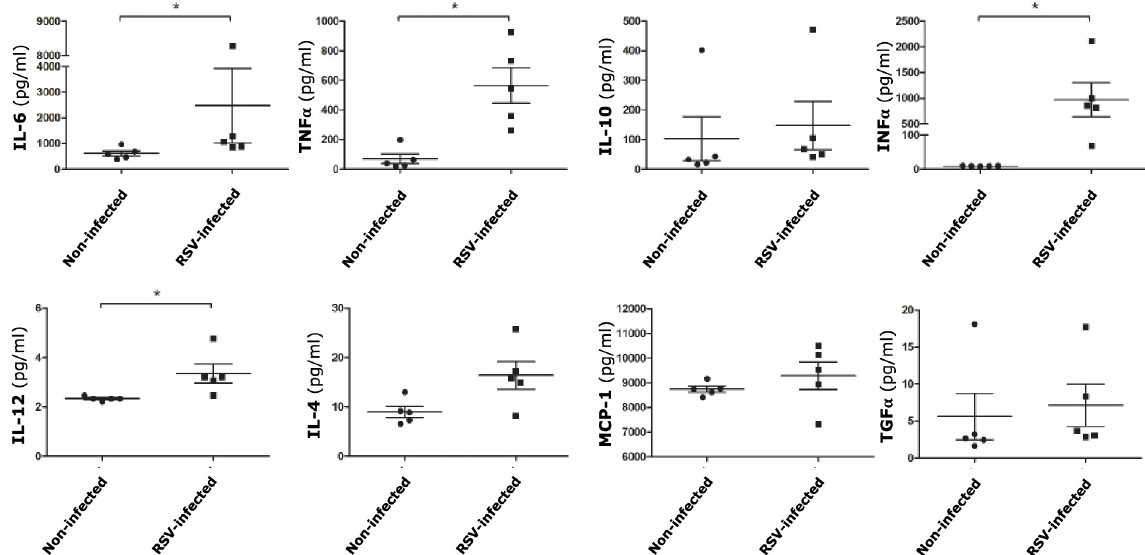
Fig 5. Cytokine expression of Hofbauer cells following infection with RSV. Cytokines concentration in supernatants collected at 24 hours post-infection with rrRSV at MOI of 1 were measured using the Luminex/Magpix magnetic bead platform, with the exception of TNF-alpha that was measured by conventional sandwich ELISA. The supernatants of infected Hofbauer cells exhibited significantly increased expression of the proinflammatory cytokines IL-6, TNF-alpha, IFN-gamma, and IL-12. Data are mean ± SEM; n = 5 donors; � p < 0.05 vs. non-infected